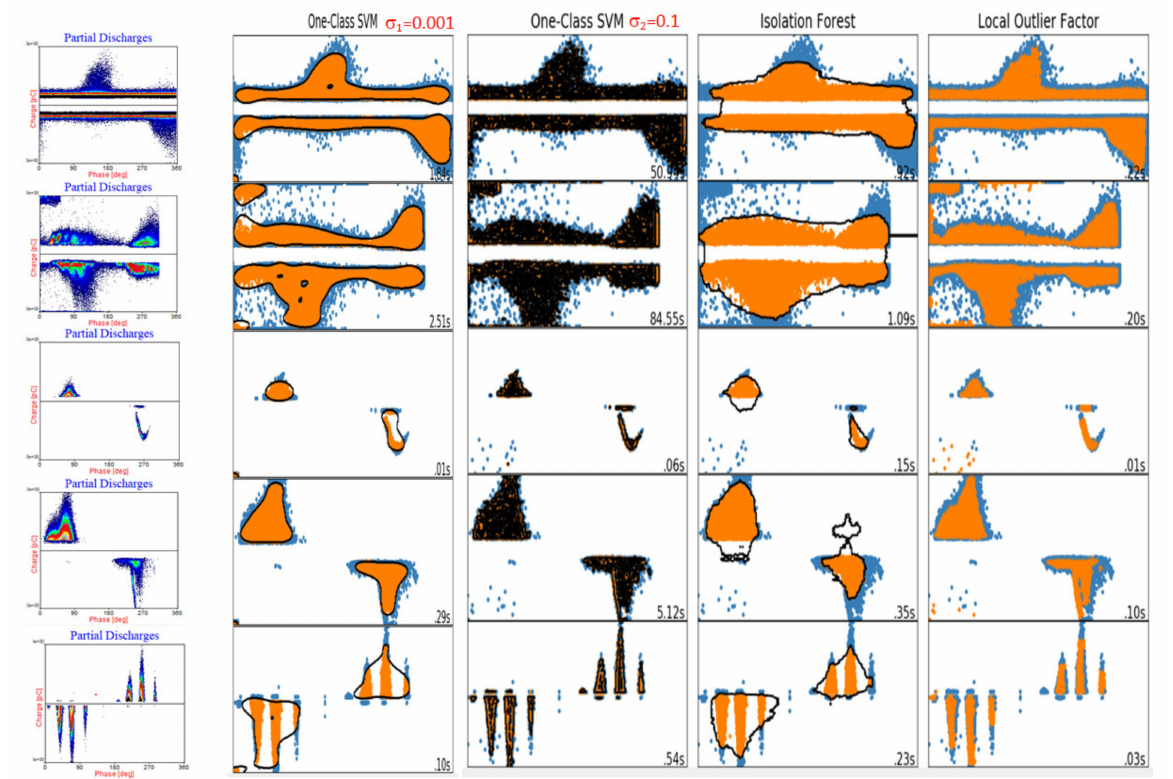
Figure 10. Anomaly detection in PD images applying three algorithms: OneClassSVM (for kernel parameters of σ 1 = 0.001 and σ 2 = 0.1), Isolation Forest, and Local Outlier